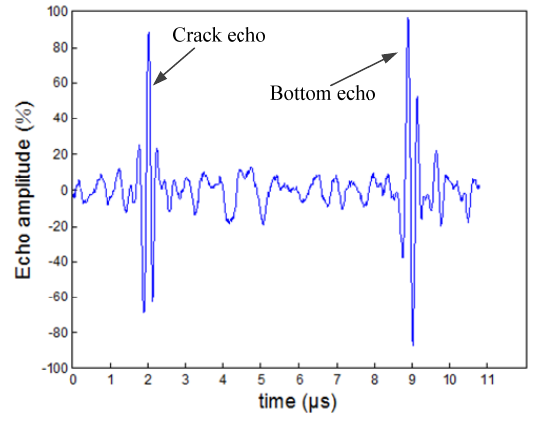
Figure 7. Crack echo wave and bottom echo wave.